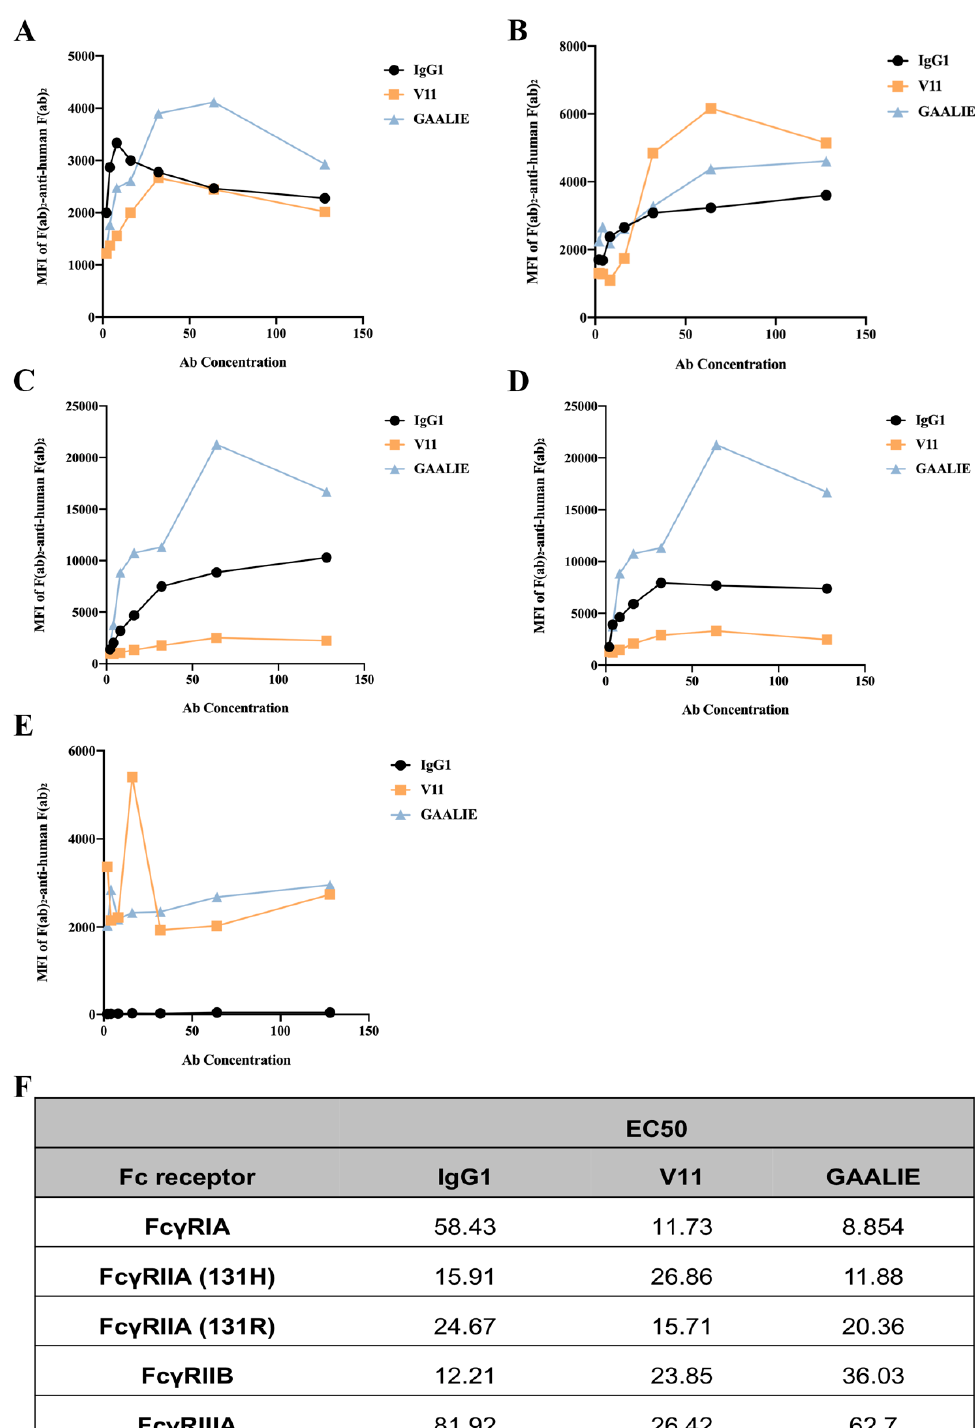
Figure 6. Affinity between Fc-engineered antibodies and Fc γ Rs. ( A ) Affinity of Fc γ RIA for Fc-engineered antibodies. ( B ) Affinity of Fc γ RIIB for Fc-engineered antibodies. ( C ) Affinity of Fc γ RIIA-H for Fc-engineered antibodies. ( D ) Affinity of Fc γ RIIA-R for Fc-engineered antibodies. ( E ) Affinity of Fc γ RIIA for Fc-engineered antibodies. ( F ) The EC50 results of Fc γ R binding to the Fc-engineered antibodies. n ≥ 3 independent experiments.